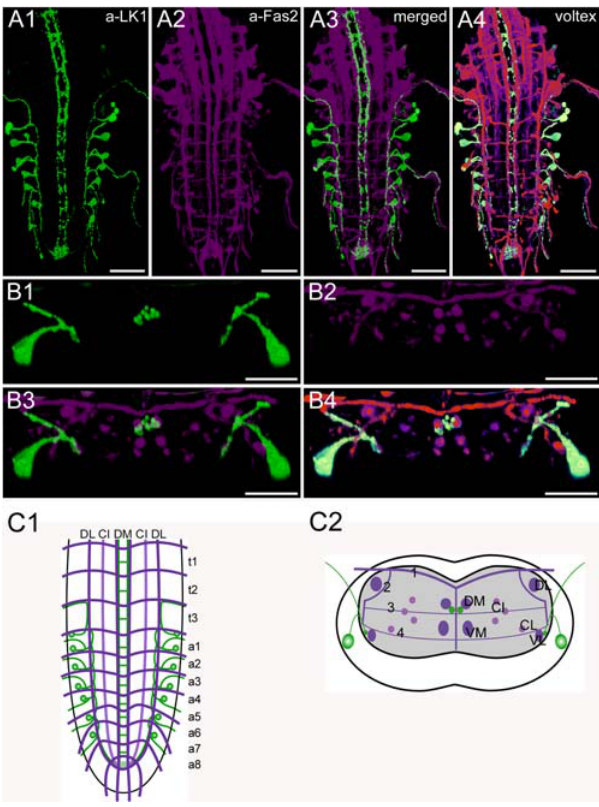
Figure 10. Morphology of MIP neurons. Mapping of Pea-MIP-IR neurons in whole-mount preparations of the thoracic and abdominal neuromeres of L3 larva in the Fas2 landmark system. A) Dorsal view. B) Transversal view at the height of neuromere a2. C) Idealized dorsal scheme. D) Idealized transverse scheme. Scale bars: 50 m m in A ), 25 m m in B ). Immunostaining is shown in green, Fas2 in